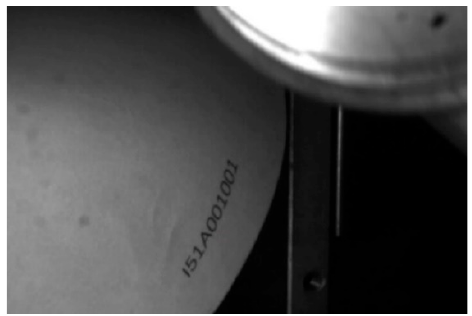
Figure 3. A frame in the video.